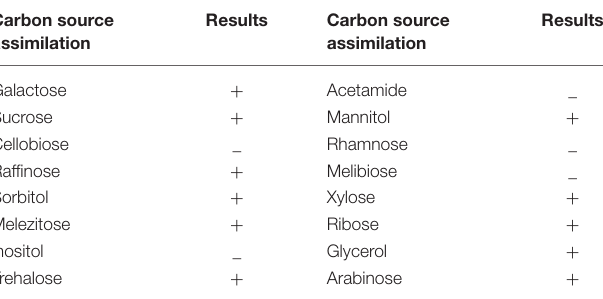
TABLE 2 | Carbon source assimilation of Rhodotorula mucilaginosa TZR 2014